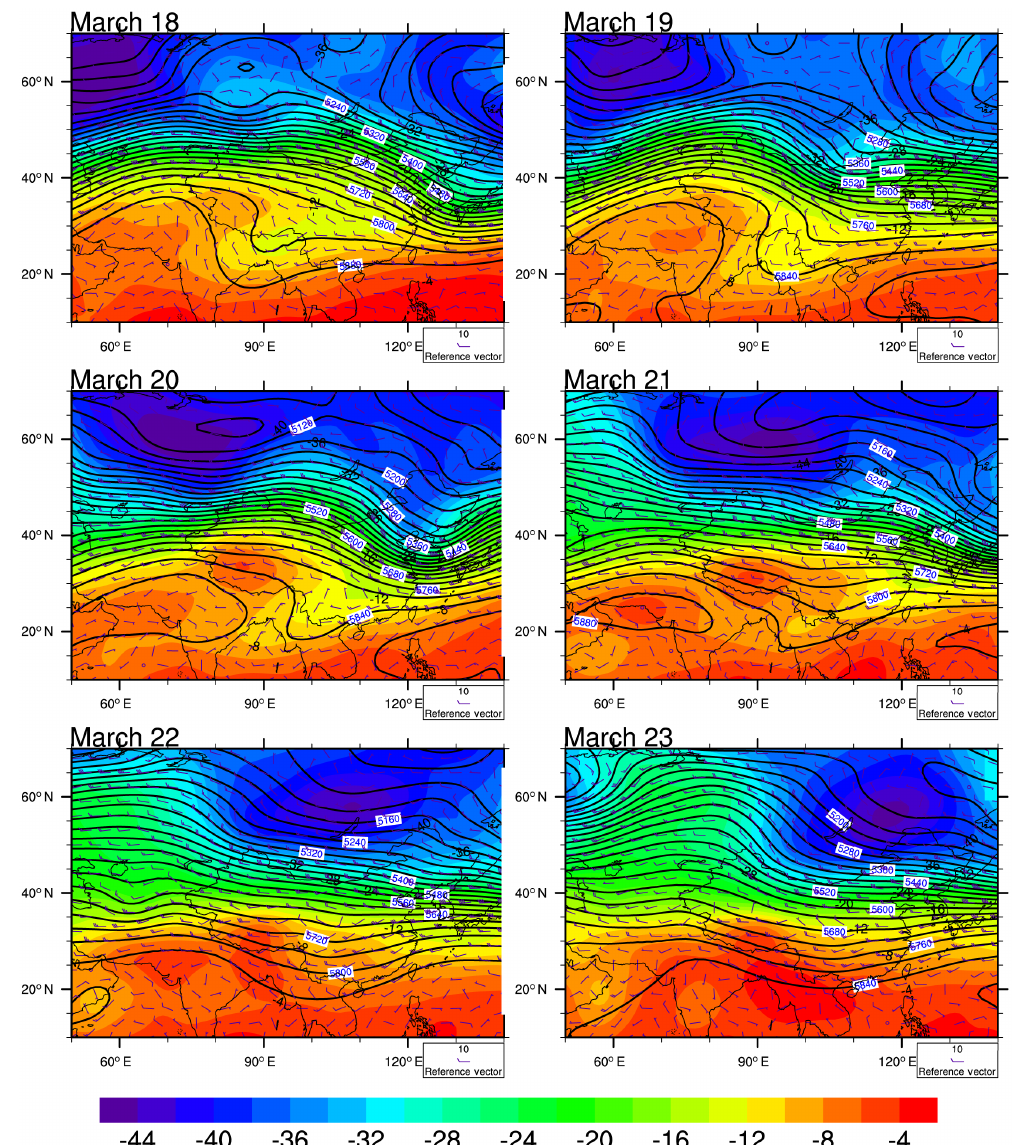
Figure 7. Spatial distributions of the geopotential height (blue lines, unit: gpm) and temperature (color, unit: ◦ ) at 500hPa from the NCEP/FNL reanalysis data over East Asia during the simulation period. The vectors represent the wind field at 500hPa (m × s − 1